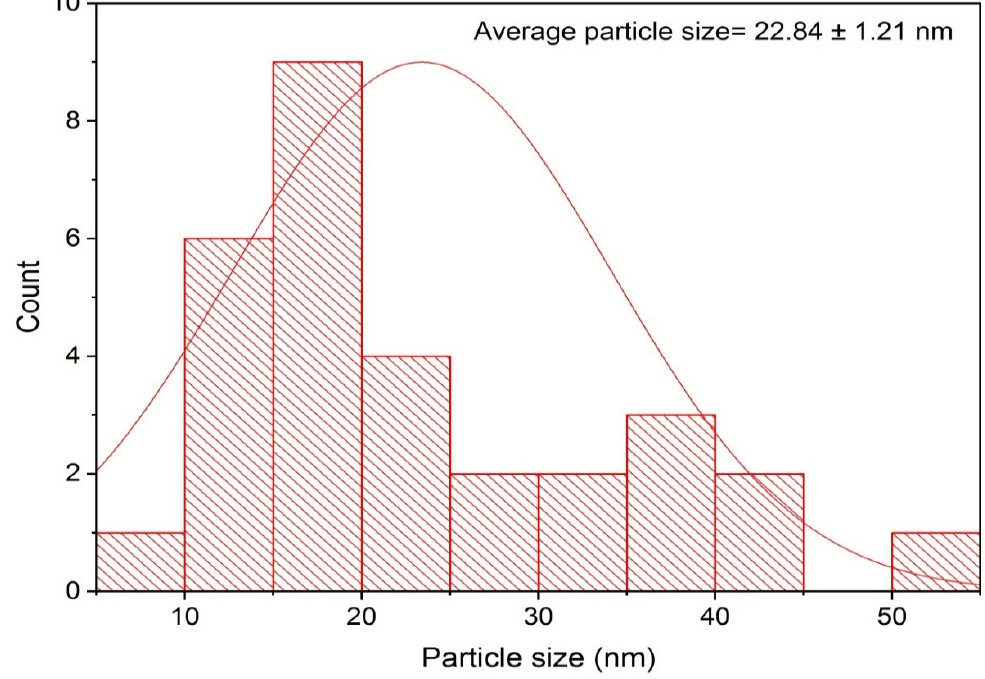
Figure 5. Particle size distribution of zinc oxide nanoparticles synthesized using aqueous pome- granate